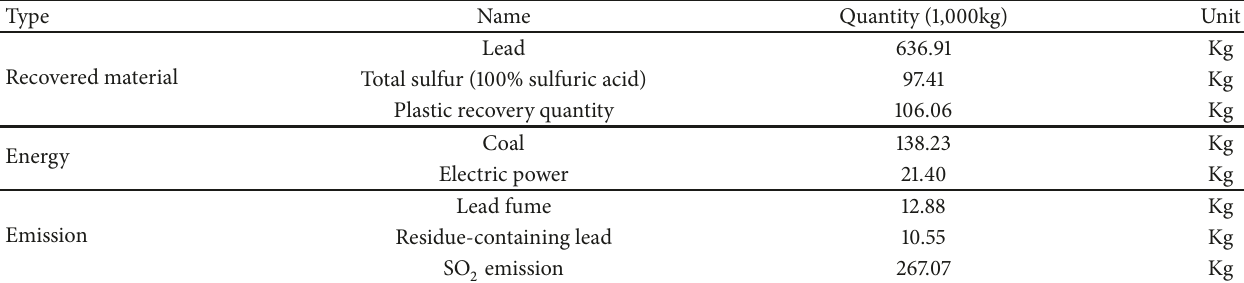
Table 14: Recovery list of disposal link of lead-acid batteries (Zhang H. Wang et al. 2013)